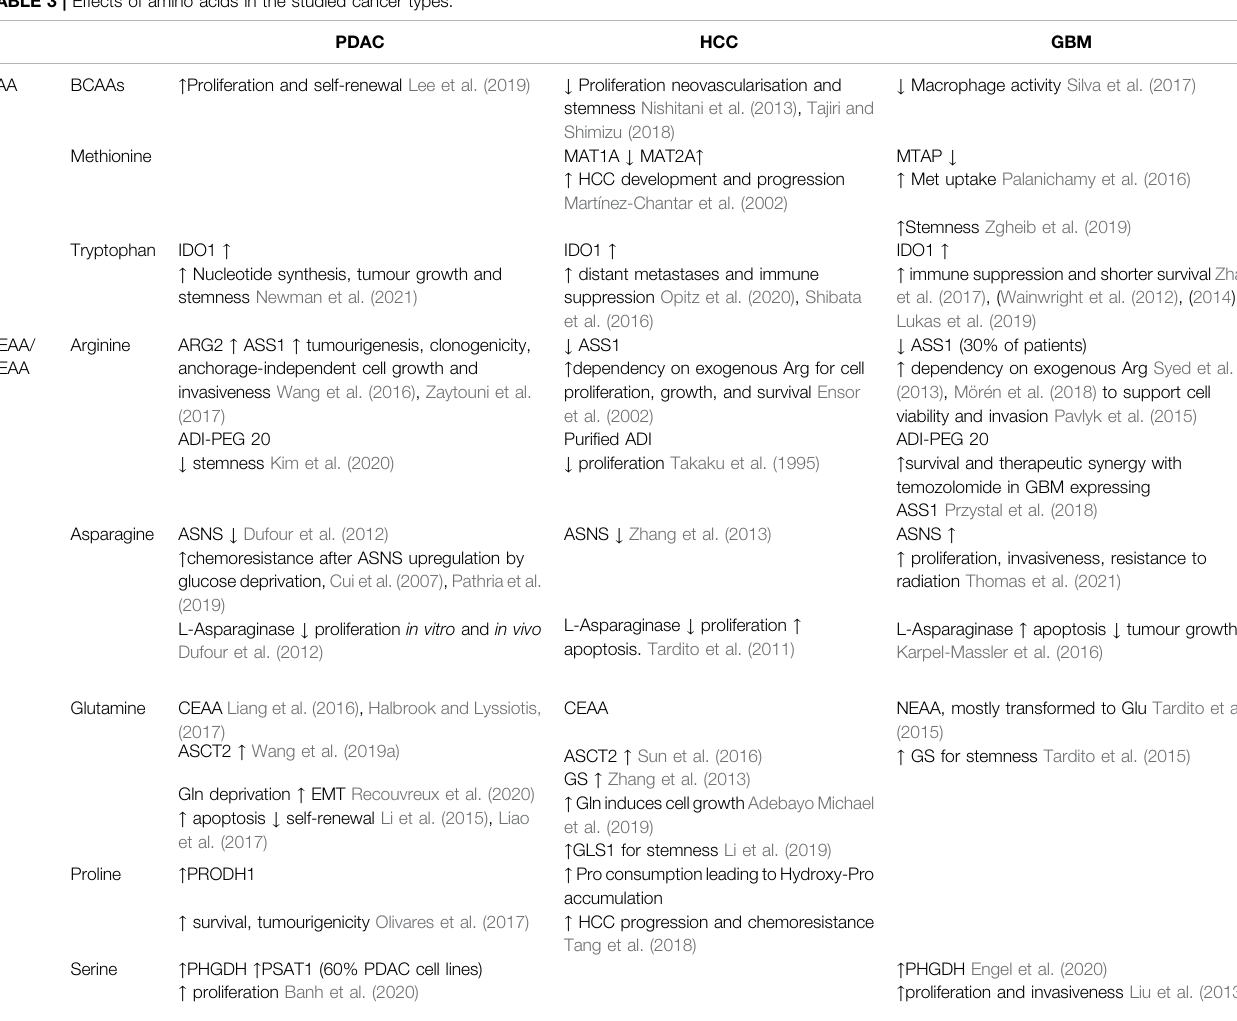
TABLE 3 | Effects of amino acids in the studied cancer